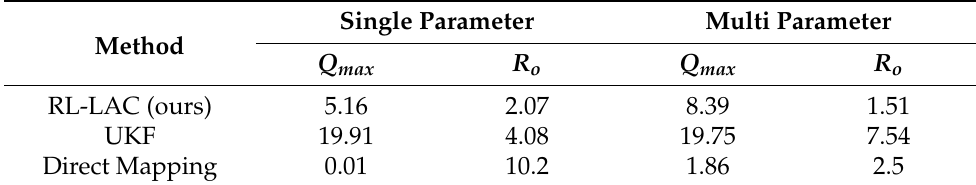
Table 1. Parameter inference (normalized root mean squared error (normalized RMSE) in % for different methods). Single parameter = vary only one parameter (either Q max or R o ) at a time. Multi parameter = vary both parameters simultaneously. RL-LAC = reinforcement learning Lyapunov- based actor–critic; UKF = unscented Kalman